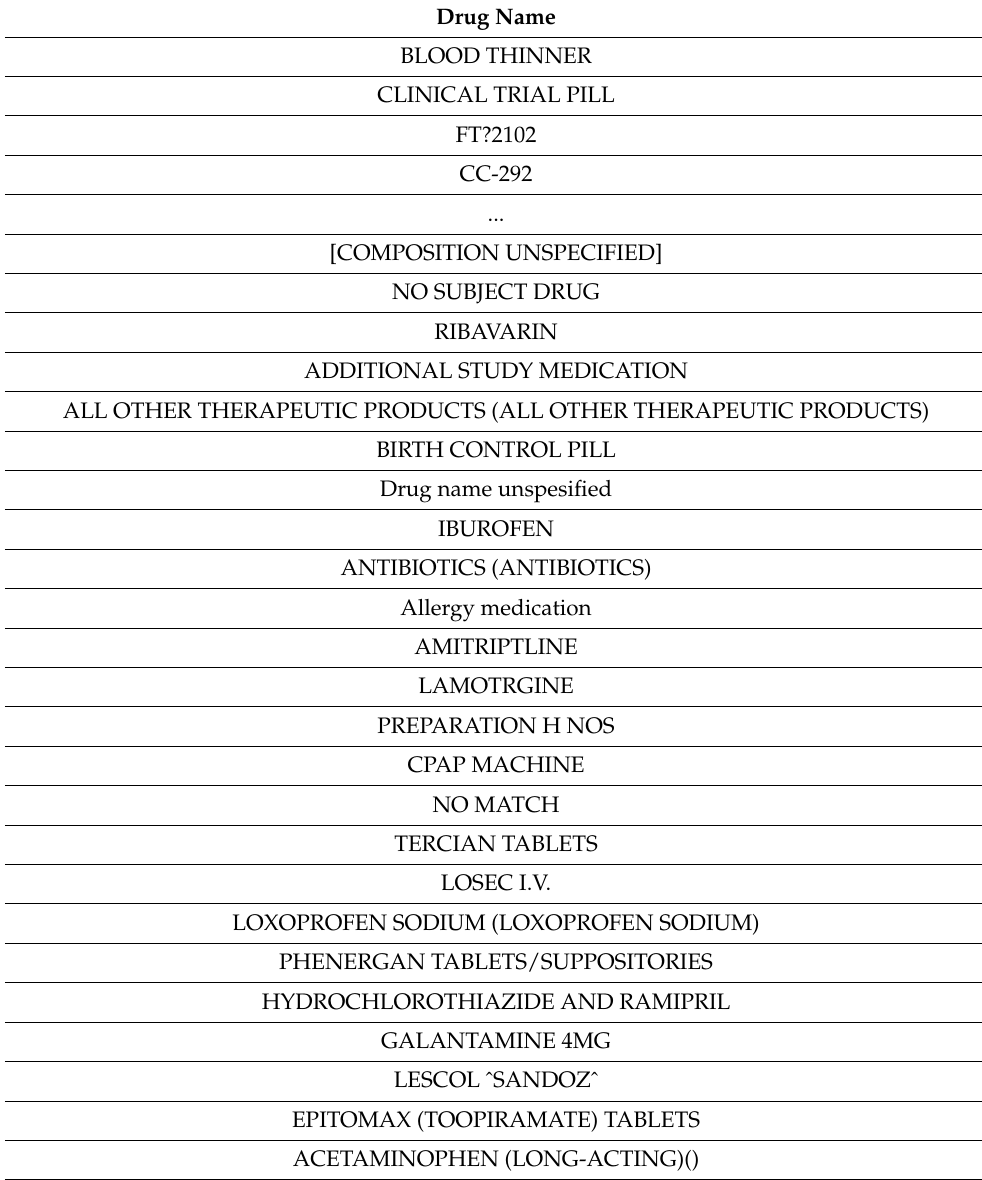
Table 2. Examples of unidentified entries after exact string matching with